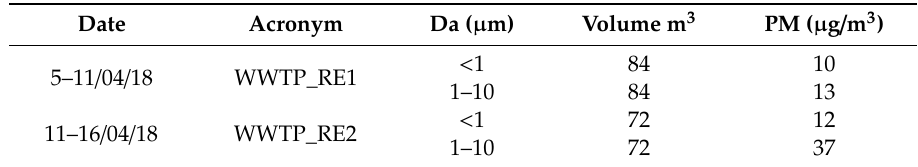
Table 1. Sampling campaigns performed in the wastewater treatment plants (WWTPs), located in central Italy.